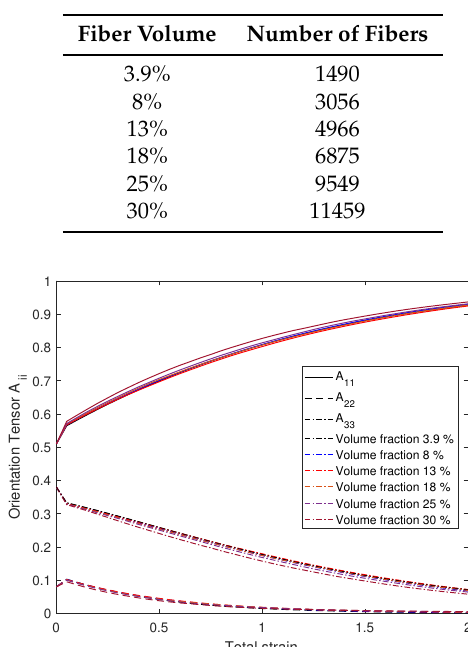
Table 5. Volume fractions and number of fibers in the respective RVEs for analyzing the influence of fiber content on fiber orientation under elongational flow.